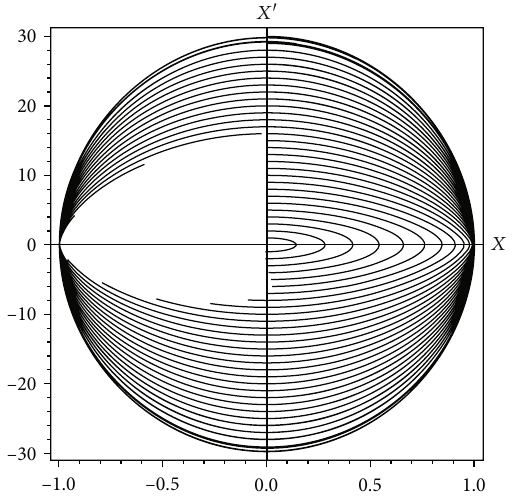
Figure 21: Solutions of the Cauchy problems (38), x ð 0 Þ = 0 , x ′ ð 0 Þ = i , and i = 1, 2, ⋯ , 30 on the interval ð 0, π /7 Þ .